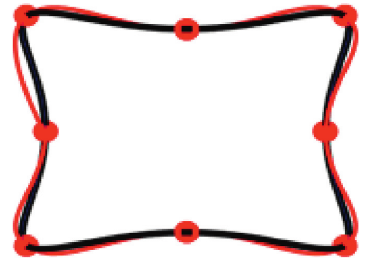
Figure 15: Cubic spline fitted for 1st iteration of GA.